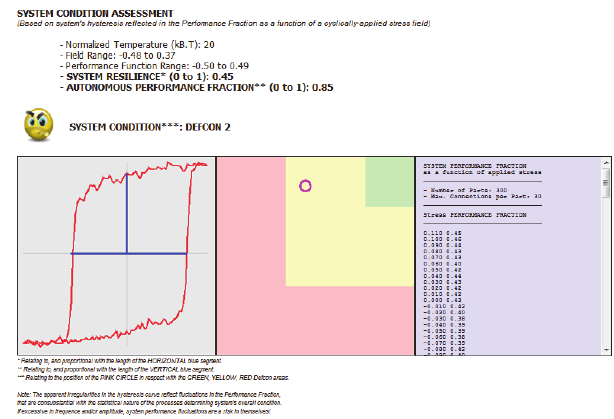
Figure 8 . System response to cyclic stress (hysteresis pattern) for a 60% technology substitution.